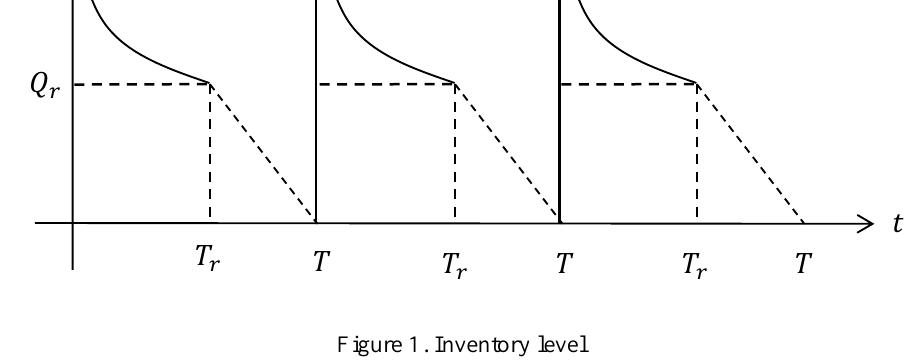
Figure 1. Inventory